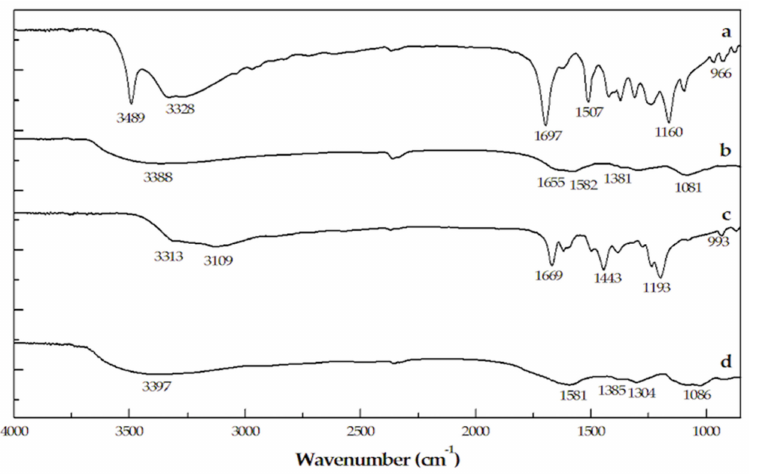
Figure 2. FT-IR spectra of ( a ) HGA monomer and ( b ) HGAm pigment, ( c ) GA monomer, and ( d ) GAm